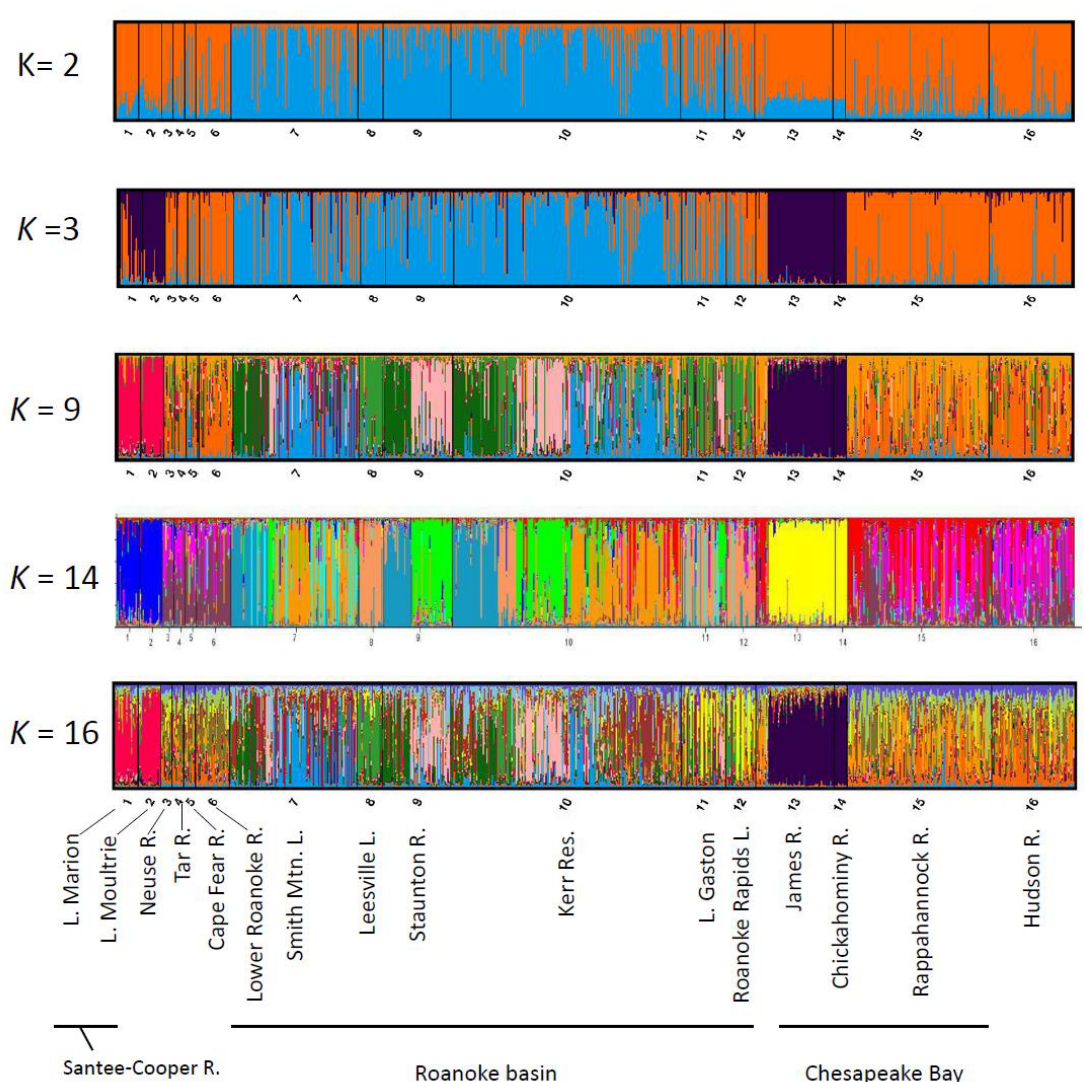
Figure 4. STRUCTURE plots representative of population genetic structuring of striped bass ranging from South Carolina to the Hudson River.